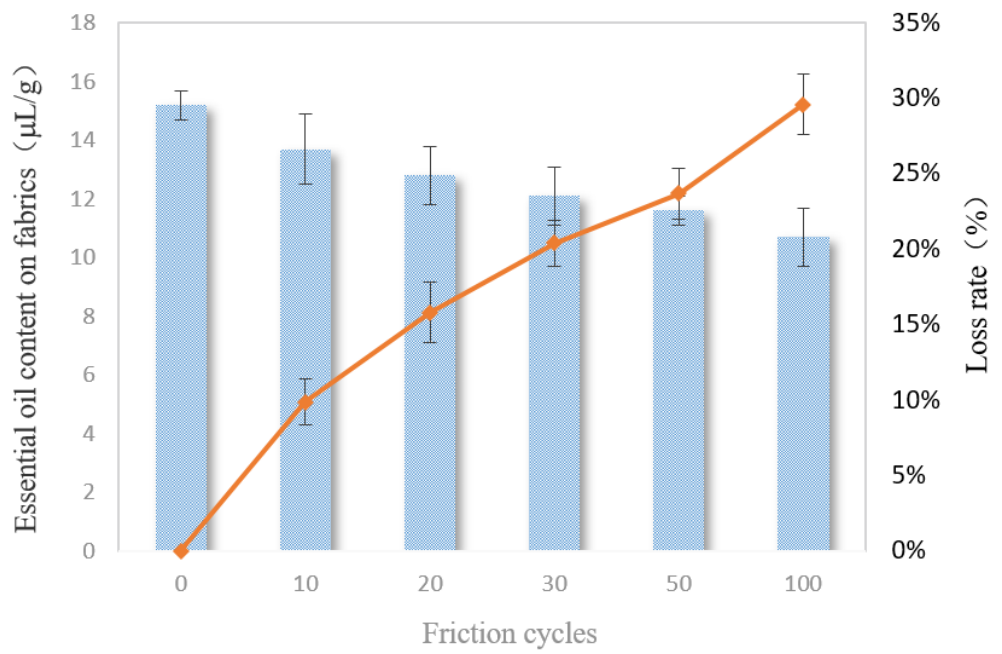
Figure 10. The friction resistance of the finished fabrics.